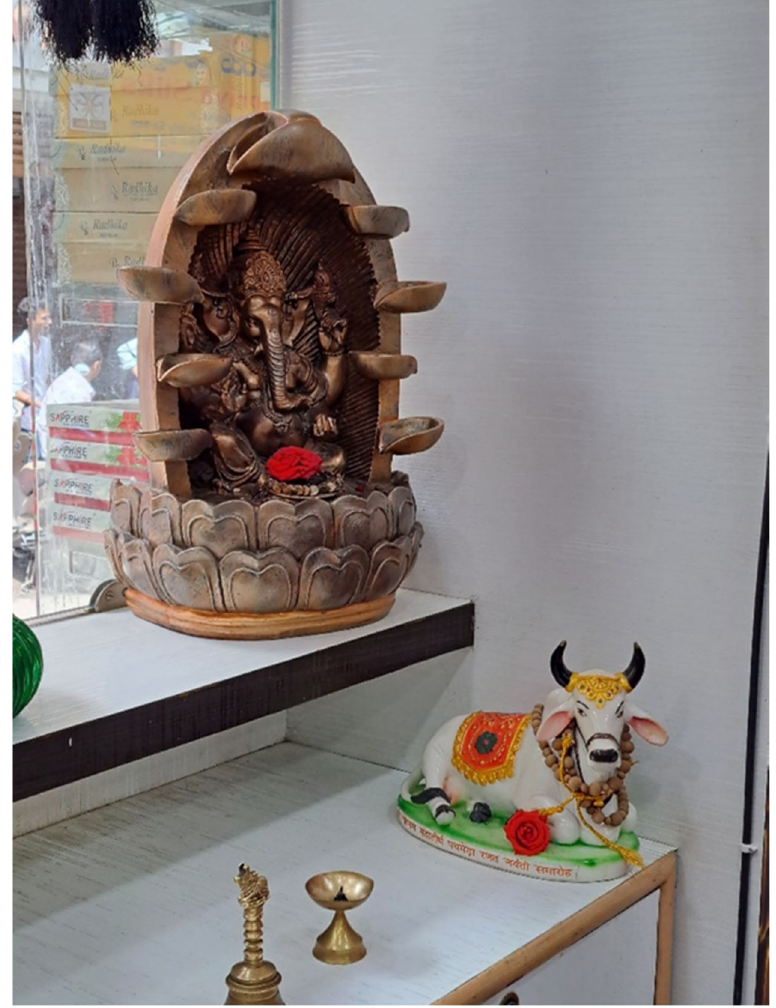
Figure 3. Ganesha on the counter of a wholesale shop in Bangalore. Picture taken by author, 23 August 2022, Bangalore.